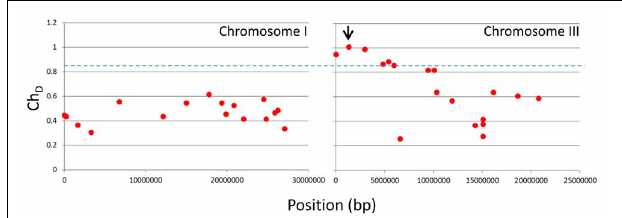
FIGURE 4 | Overview of workflow for different SNP calling pipelines. The commonalities and differences between the four SNP calling pipelines are illustrated with the black arrow indicating the direction of the workflow. A detailed overview encompassing specific commands is provided in Supplementary Figure 1 . All pipelines generate a SNP file for both parent and mutant lines, after which scripts and filters were used to generate a SNP file for the mutant line lacking parental specific SNPs.